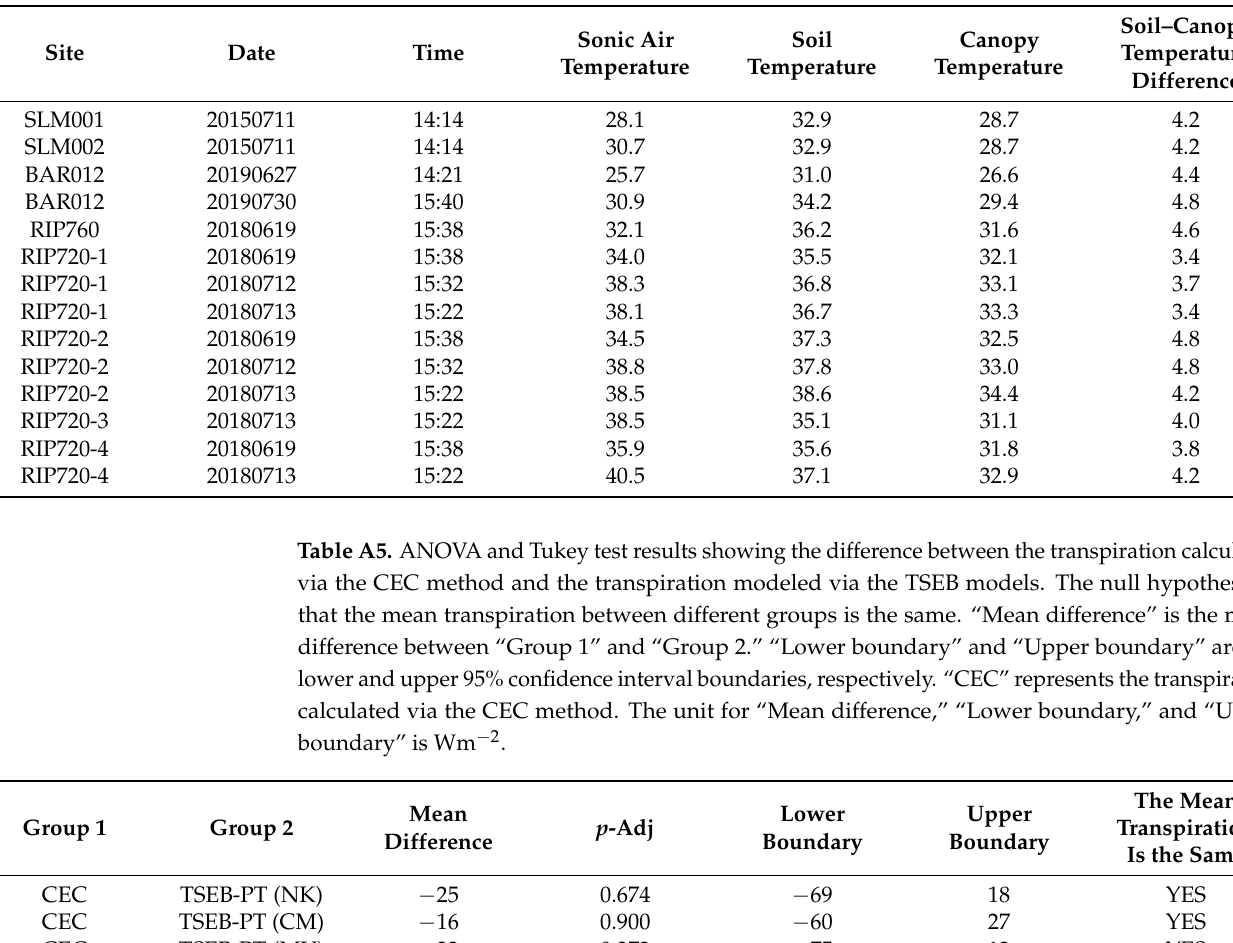
Table A4. Separated average soil and canopy temperatures within the corresponding footprint area via the QTS model (the temperature unit is ◦ C).